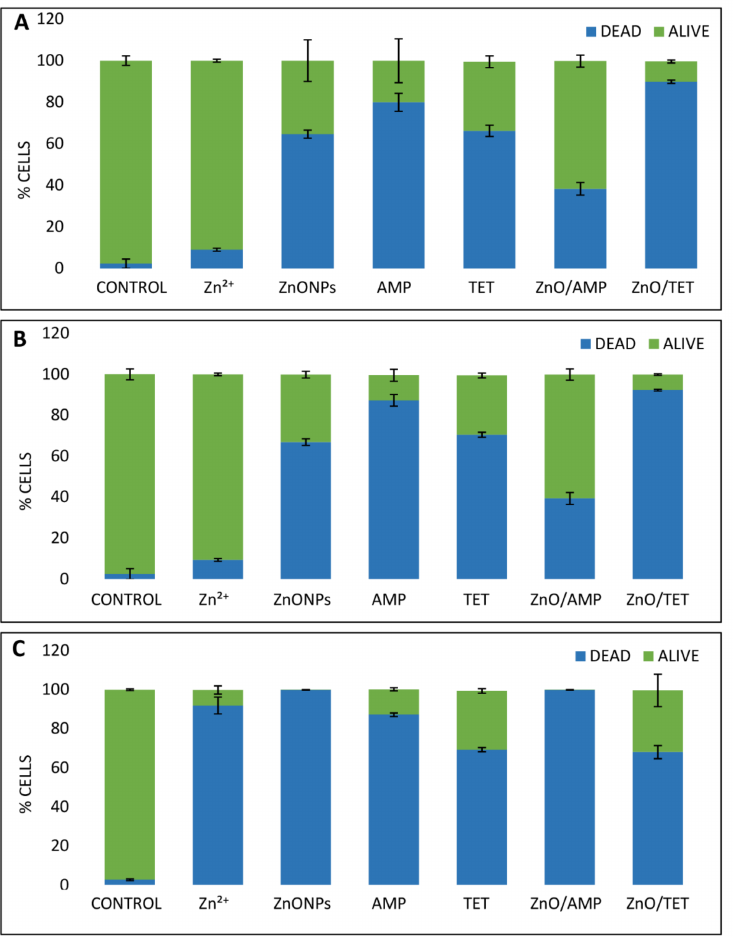
Figure 6. Changes plot of the percentage amount of live and dead E. coli ( A ), S. epidermidis ( B ) and K. pneumoniae ( C ) bacteria cells treated with ampicillin (AMP), tetracycline (TET), zinc ions (Zn 2+ ) and zinc oxide nanoparticles (ZnONPs), before and after immobilization with AMP (ZnONPs/AMP) and TET (ZnONPs/TET), as well as non-treated bacteria